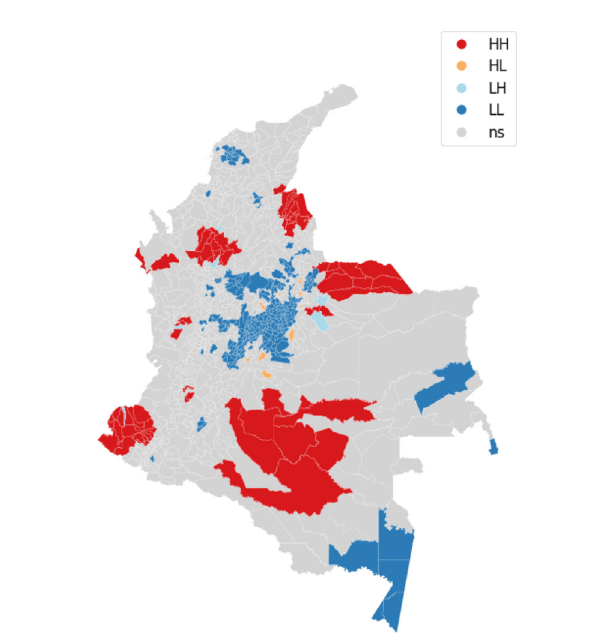
FIGURE4 The figure shows the LISA clusters